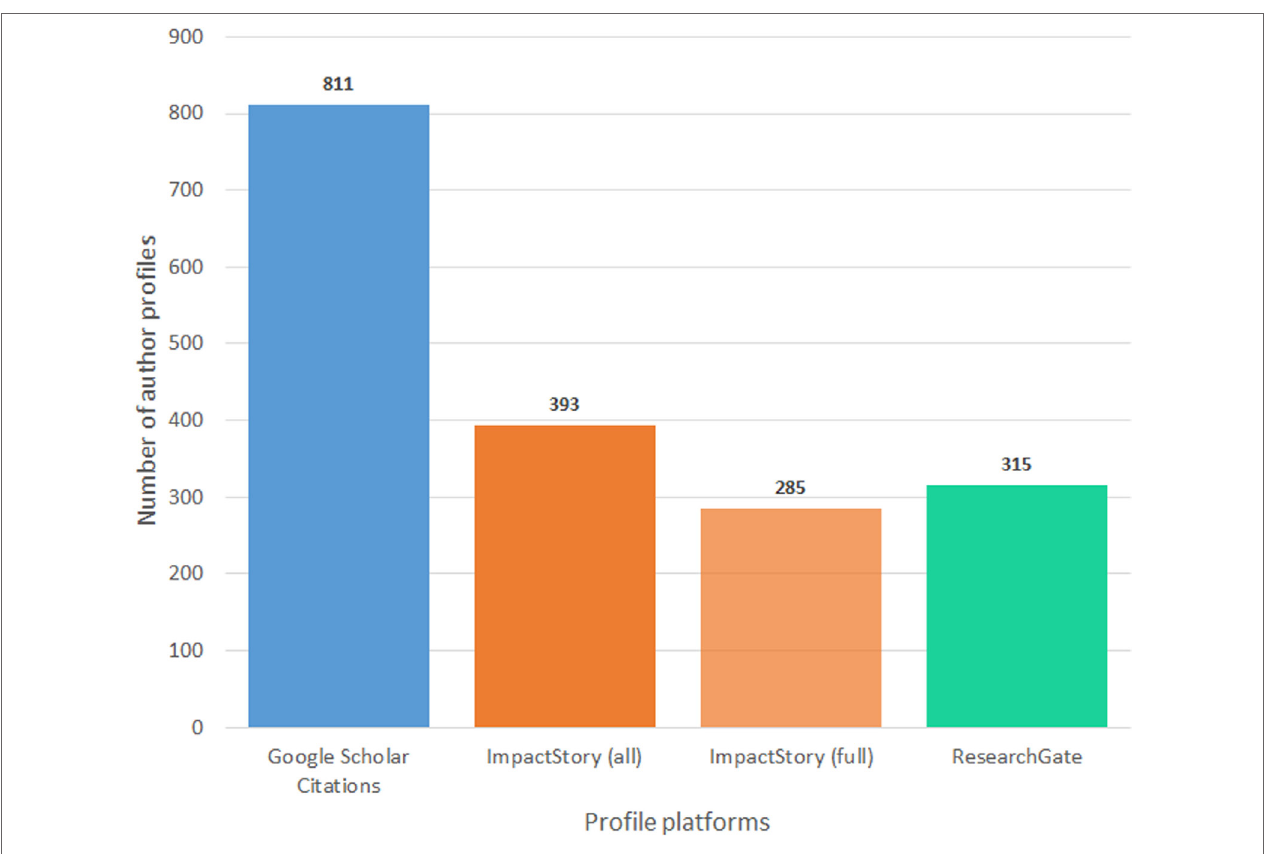
FigUre 2 | Number of profiles created in each platform.